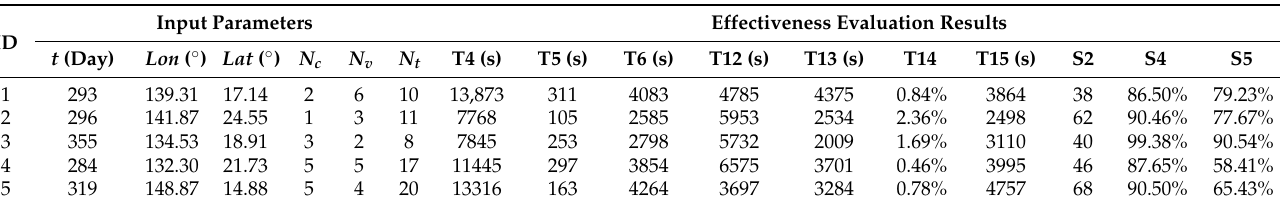
Table 8. The input parameters and effectiveness evaluation results of the first 5